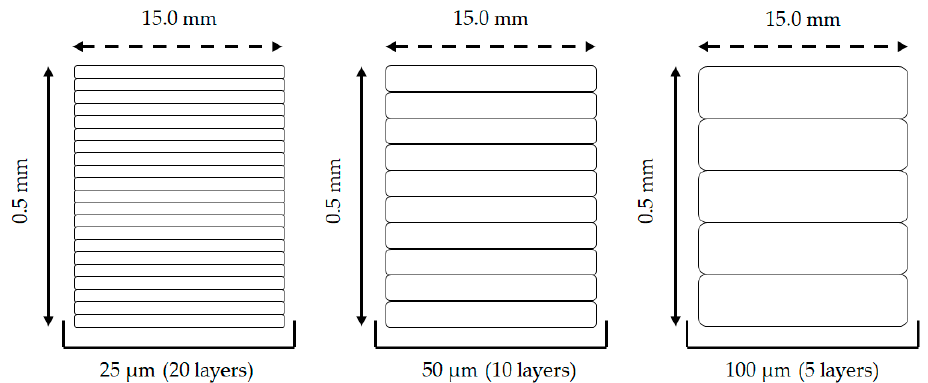
Figure 2. Illustration of the different number of layers present per scaffold using (left to right) 25, 50 and 100 µm printing resolutions.